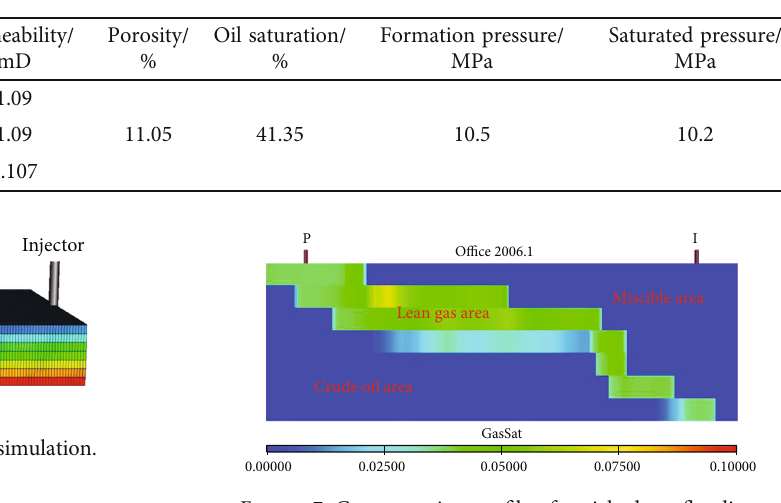
Table 3: Parameter design of numerical simulation model.